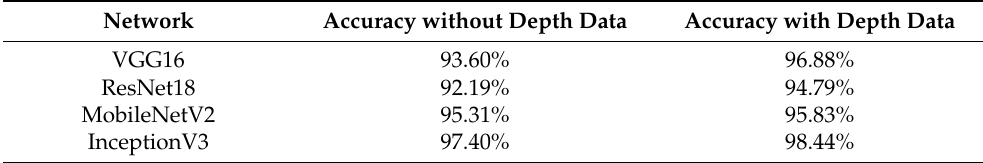
Table 6. Comparison of different model performances on classifying the flowers with the validation set.